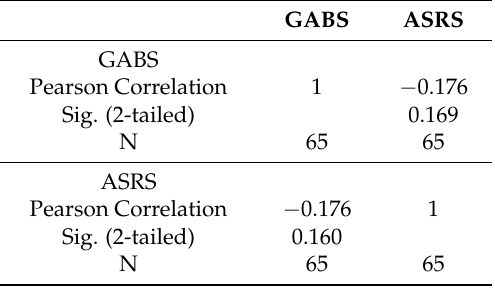
Table 5. Associations between ADHD symptoms and gambling-related